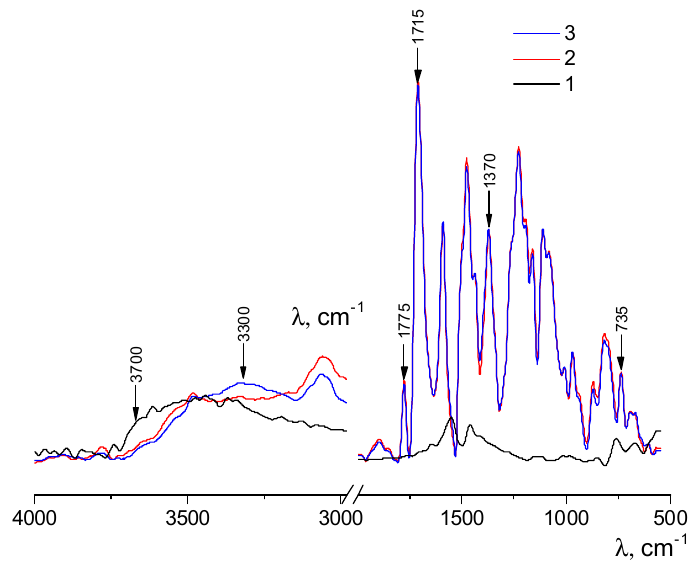
Figure 5. FT-IR spectra of zirconia nanostars ( 1 ), pristine polyimide ( 2 ) and composite film with ZrO 2 ( 3 ).